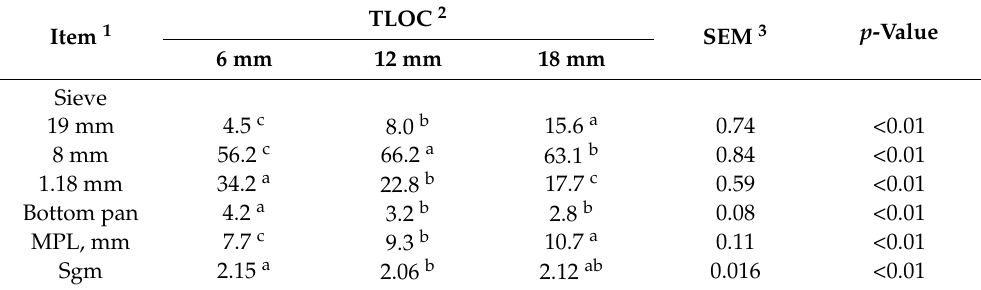
Table 6. Effect of theoretical length of cut on particle size distribution and mean particle length in whole-plant corn silage harvested with a self-propelled forage